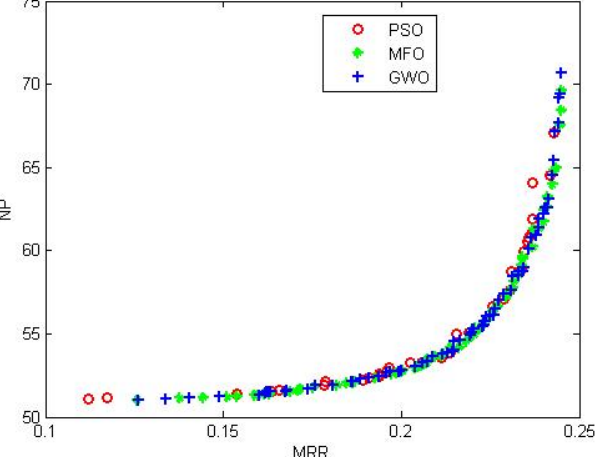
Figure 16. Pareto optimal solutions for various algorithms.